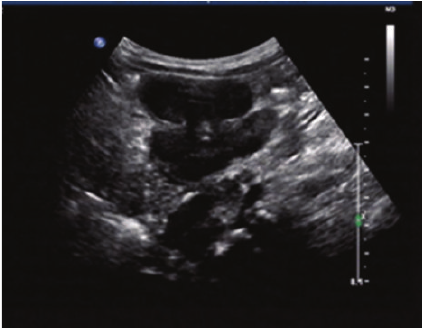
Figure 1: Ultrasound demonstrates multiple retroperitoneal lymph node enlargements.